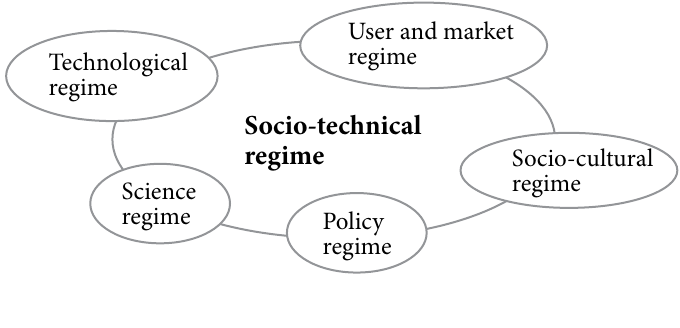
Fig. 3. Meta-coordination through socio-technical regimes (Geels